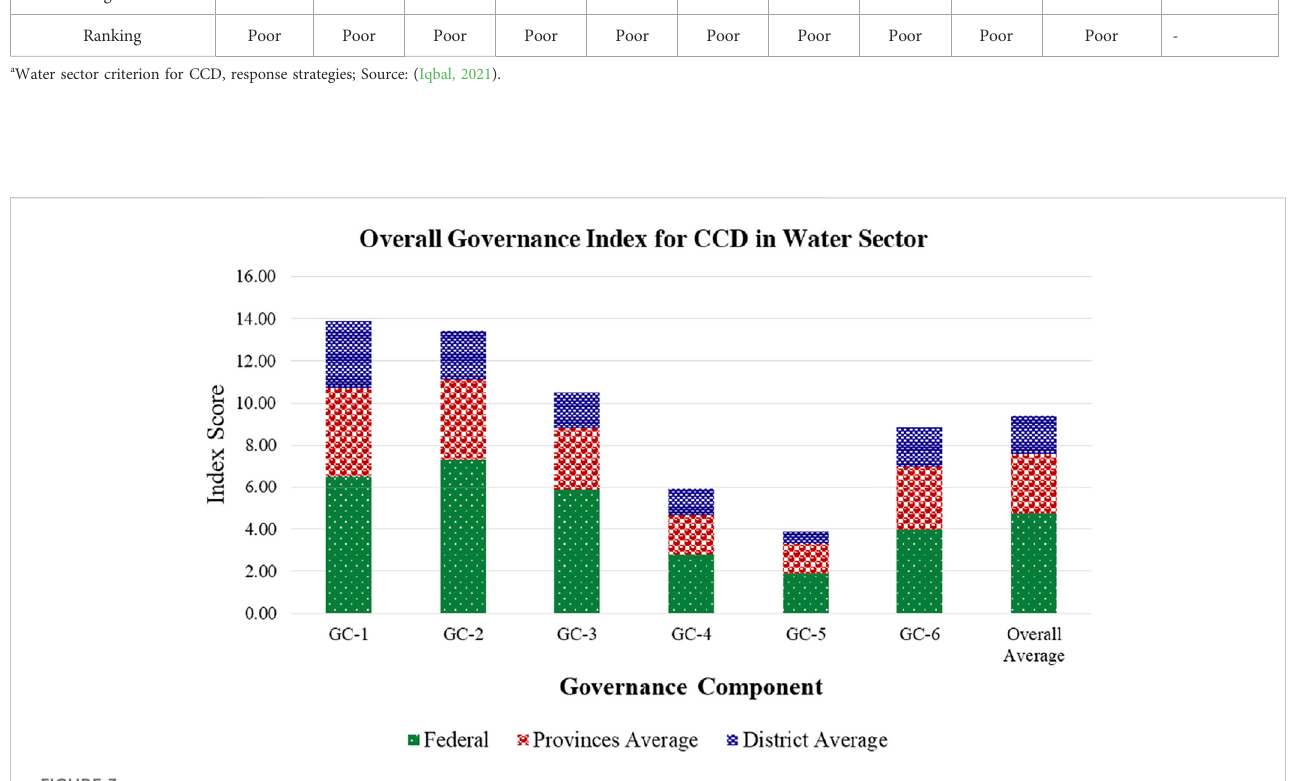
FIGURE 3 Index showing the overall state of water sector